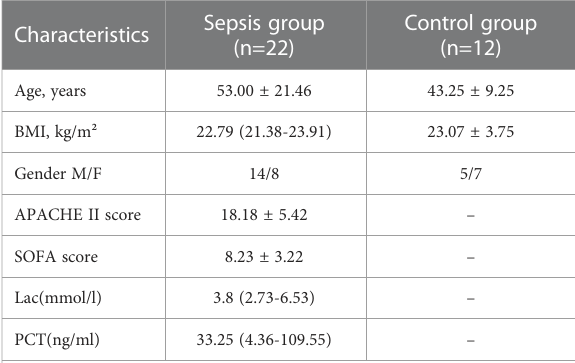
TABLE 1 General characteristics of the patients